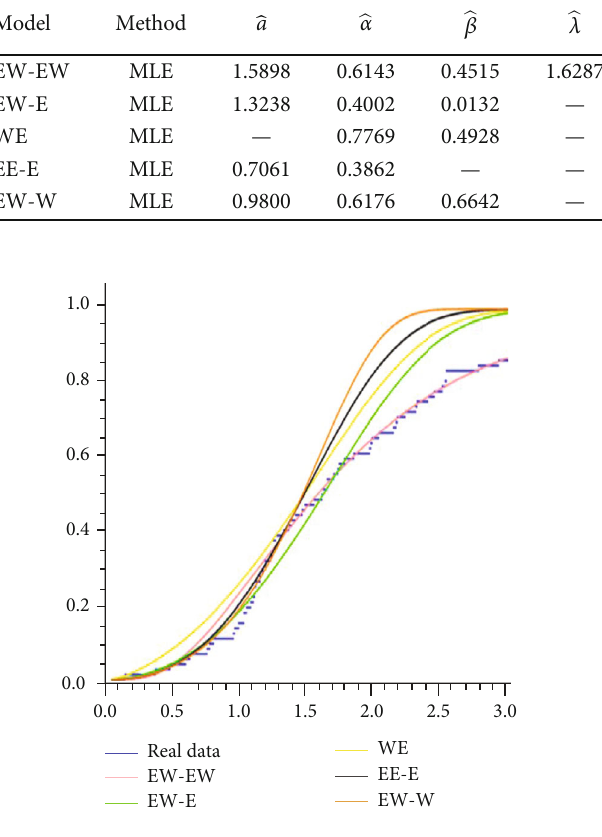
Figure 3: Plot CDF of the EW-EW, EW-E, WE, EE-E, and EW- EW with the empirical distribution for the 1 st data